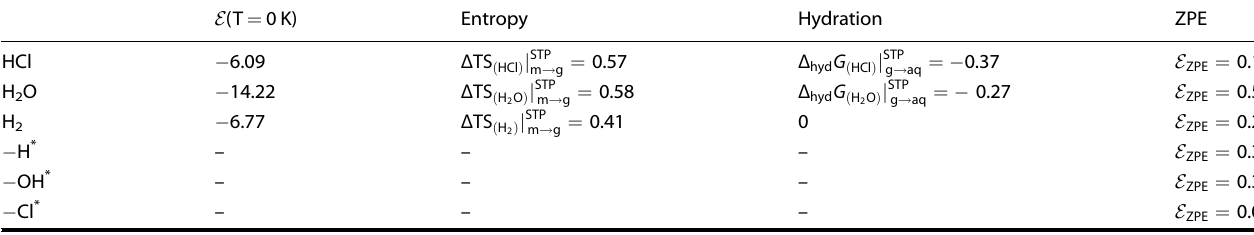
Table 1. DFT energy and thermodynamic corrections for terms from Eq. (1) to Eq. (11). E (T = 0 K) Entropy Hydration